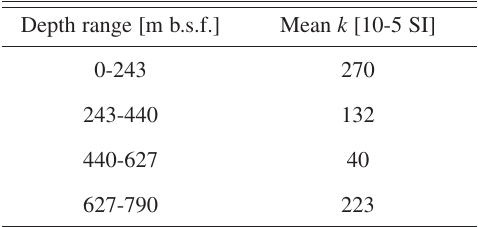
Table I. Mean k values of CRP3 drill hole (fig. 3). Depth range [m